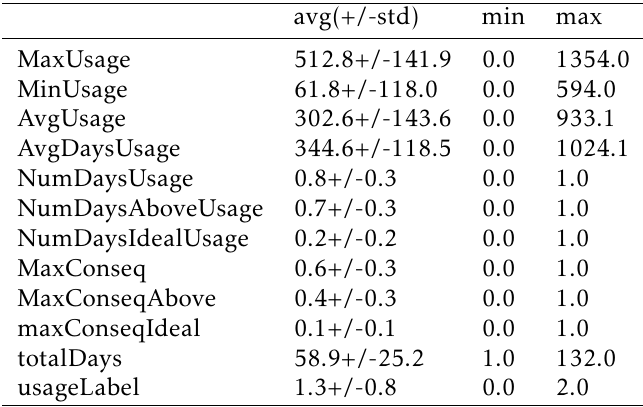
Table 1. Summary of the features related to the use of CPAP for the analysis of adherence .